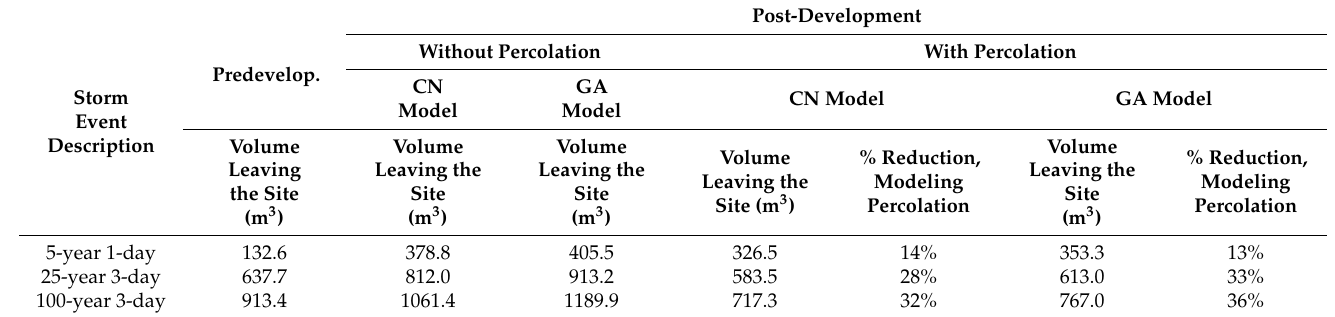
Table 9. A volumetric comparison of modeling with and without percolation links for the post- development condition.